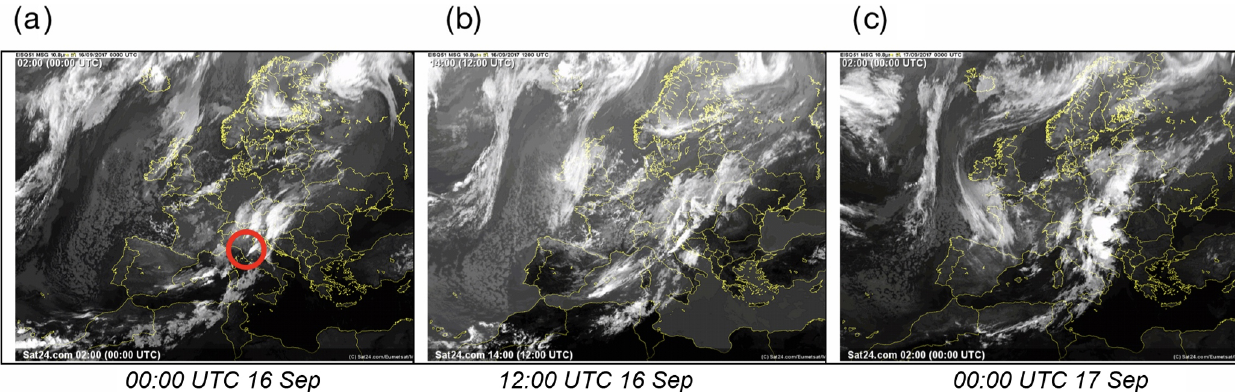
Figure 3. (a) Satellite images (METEOSAT second generation) of the infrared channel, 10.8µm, at 00:00 and 12:00UTC on 16 September, and at 00:00UTC on 17 September 2017. A well-defined cloud system is apparent inside the red circle of the image at 00:00UTC on 16 September 2017. Source: https://www.sat24.com (last access: 8 August 2019); © EUMETSAT.